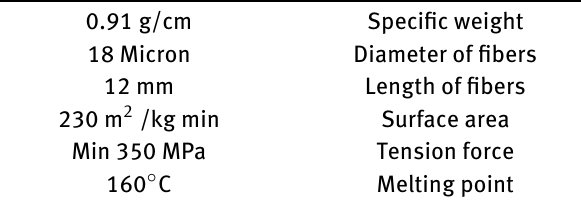
Table 1: Particle Size of Sand